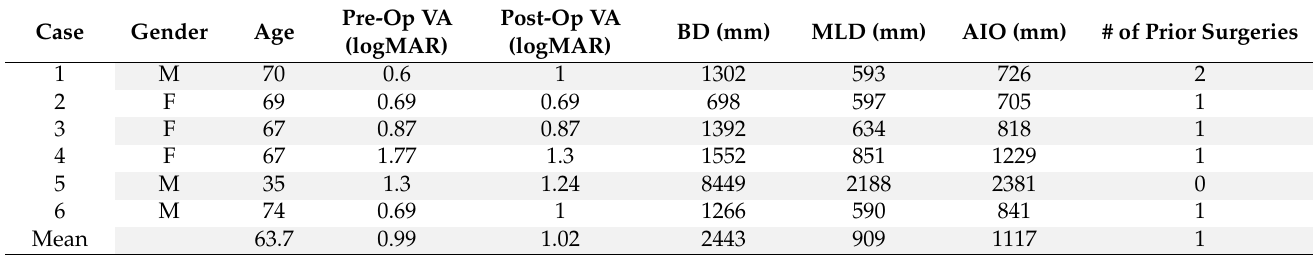
VA = visual acuity; logMAR = logarithm minimum angle of resolution; BD = basal diameter; MLD = minimum lineal dimension; AIO = apical inner opening. In eyes with MH, the baseline BCVA was 0.99 ± 0.46 logMAR (Snellen 20/195)